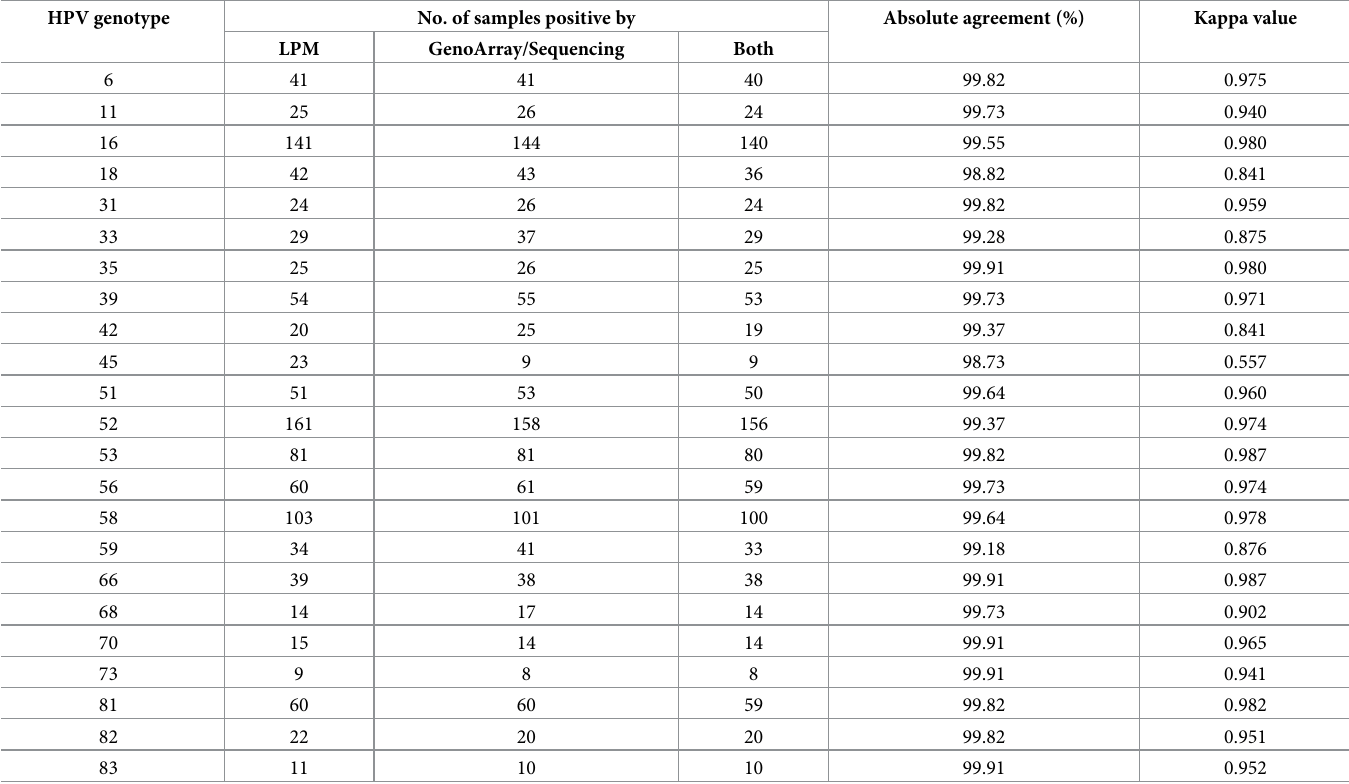
Table 4. Interassay agreements for individual HPV genotypes detected by two